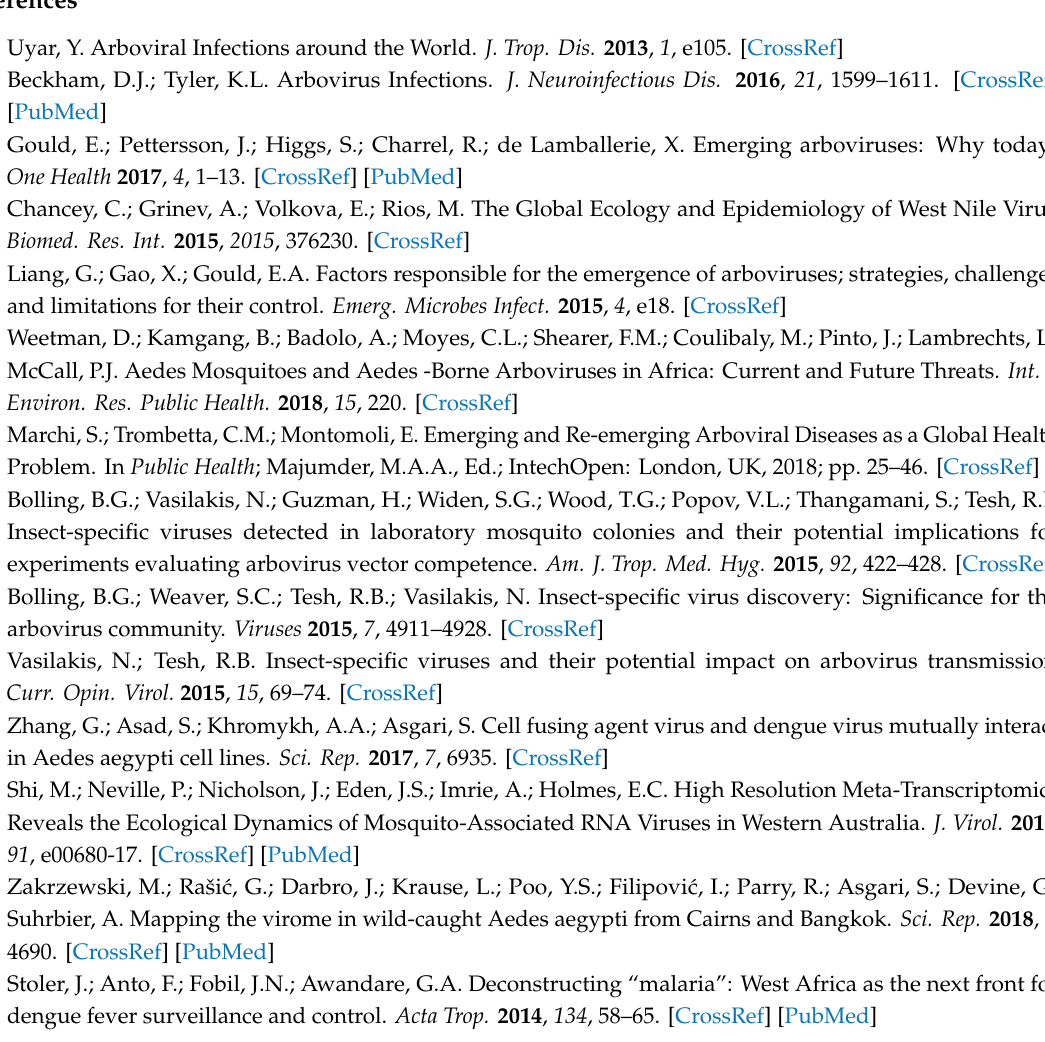
Table S1a: Mosquito pools for virus isolation and virus positive pools in 2015 and 2016. Table S1b: Mosquito collection sites and pools used for virus isolation in 2015. Table S1c: Mosquito collection sites and sampling method used in 2016. Table S2a: Classification of mosquitoes by morphological identification and DNA barcoding. Table S2b: Mosquito species and COI Genbank accession numbers. Figure S1: Phase-contrast micrographs of WAV-infected (A) and mock-infected (B) C6 / 36 cells at 3 days postinfection. Figure S2: Phase-contrast micrographs of MoCV-infected (A) and mock-infected (B) C6 / 36 cells at 6 days